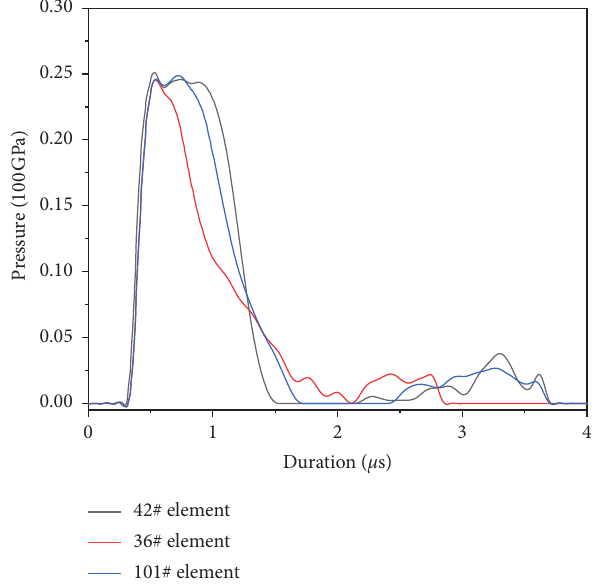
Figure 5: Pressure-time curves of typical elements.